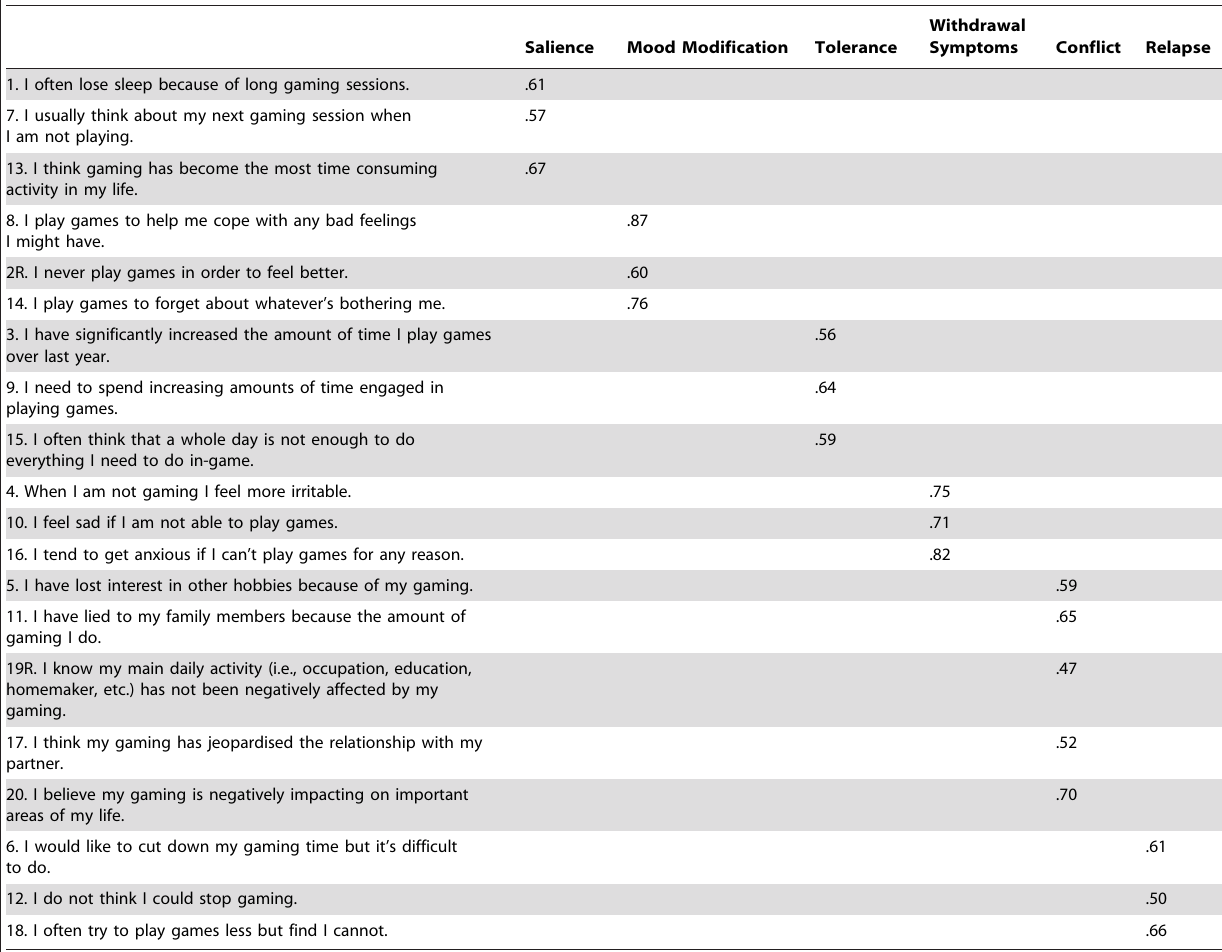
Table 3. Confirmatory Factor Analysis of the 20 items of the IGD-20 Test.